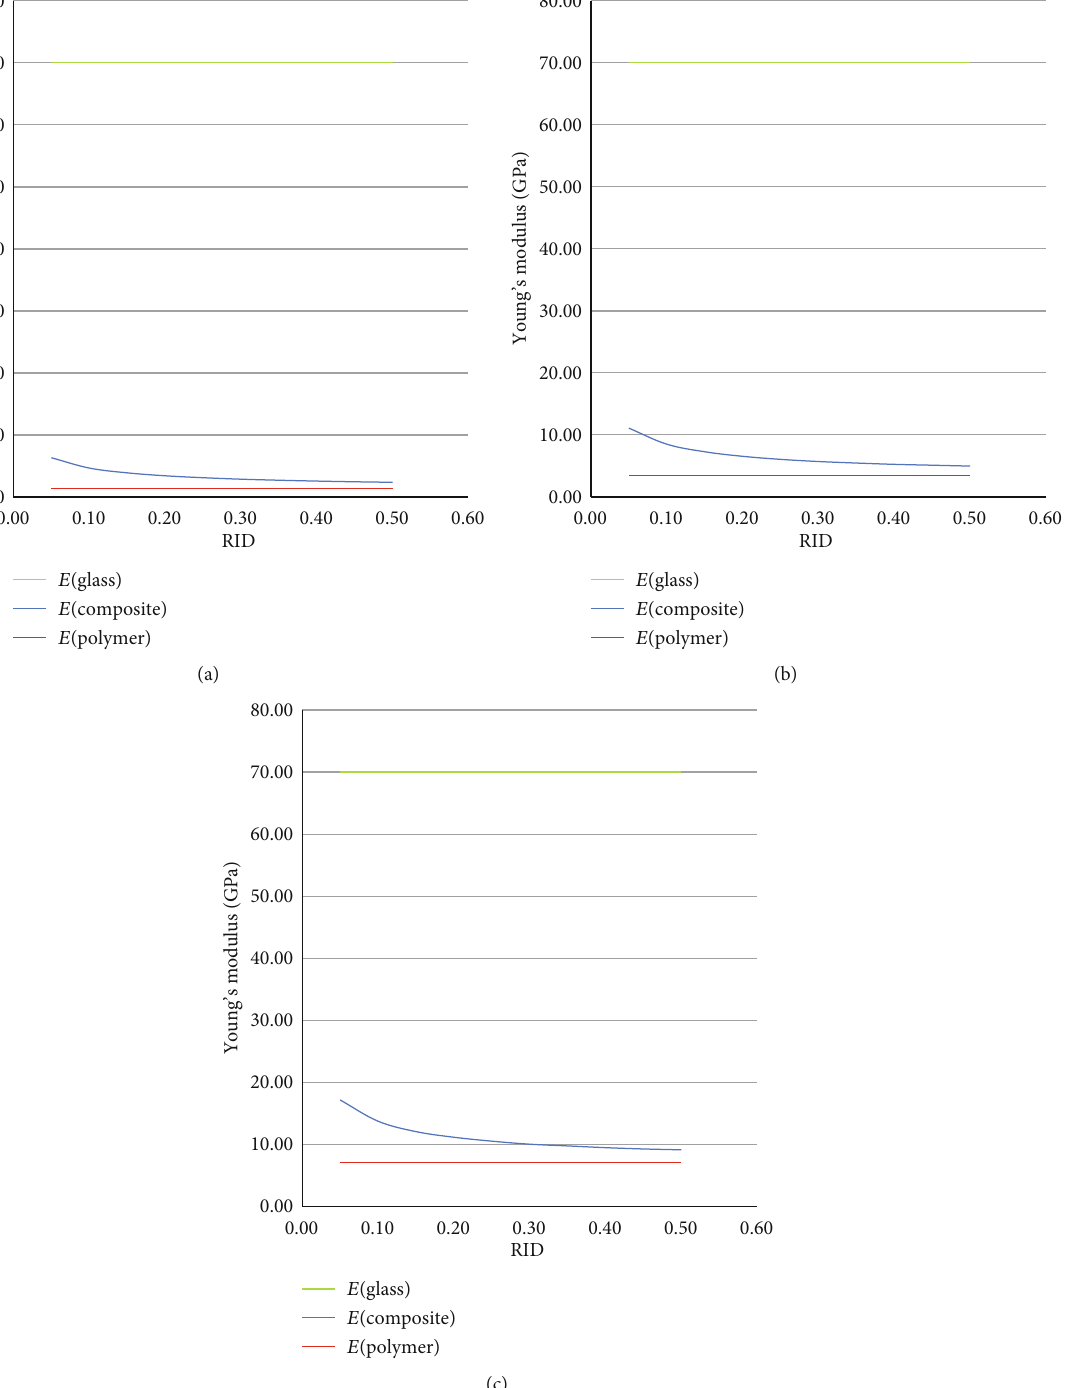
Figure 4: E (composite) changed with RID when E ð substrate Þ was (a) 1.4 GPa, (b) 3.5GPa, and (c) 7GPa,